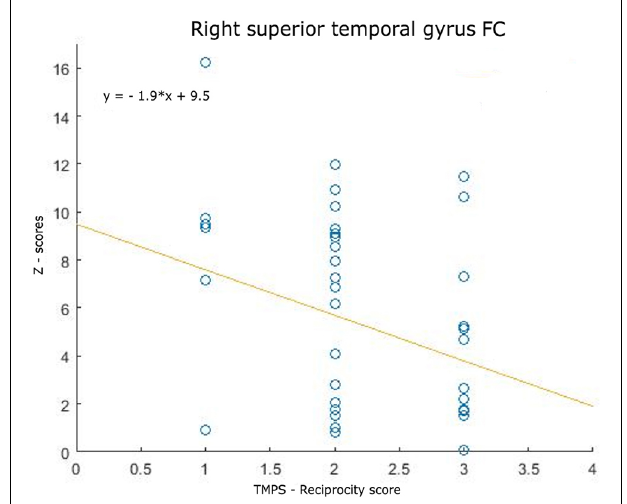
FIGURE 5 | Scatterplot of the association between resting-state functional connectivity (FC) of limbic network abnormalities (right superior temporally gyrus FC) and reciprocity score of TMPS in MS